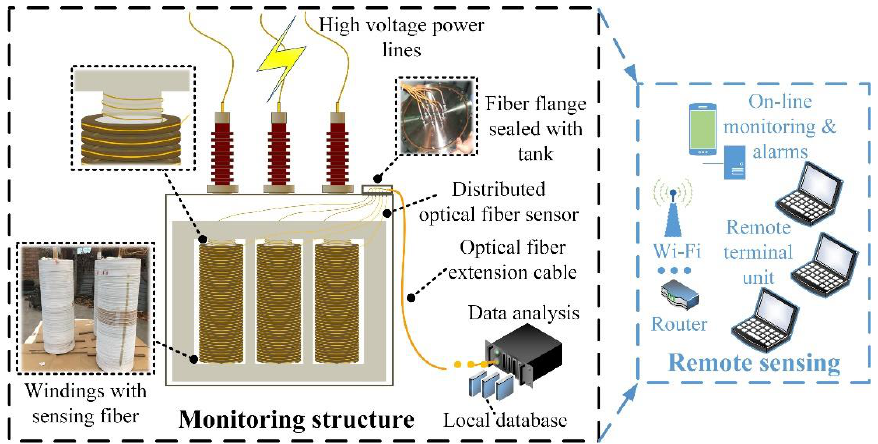
6 of 16 Table 1. Specifications of the transformer. Classification